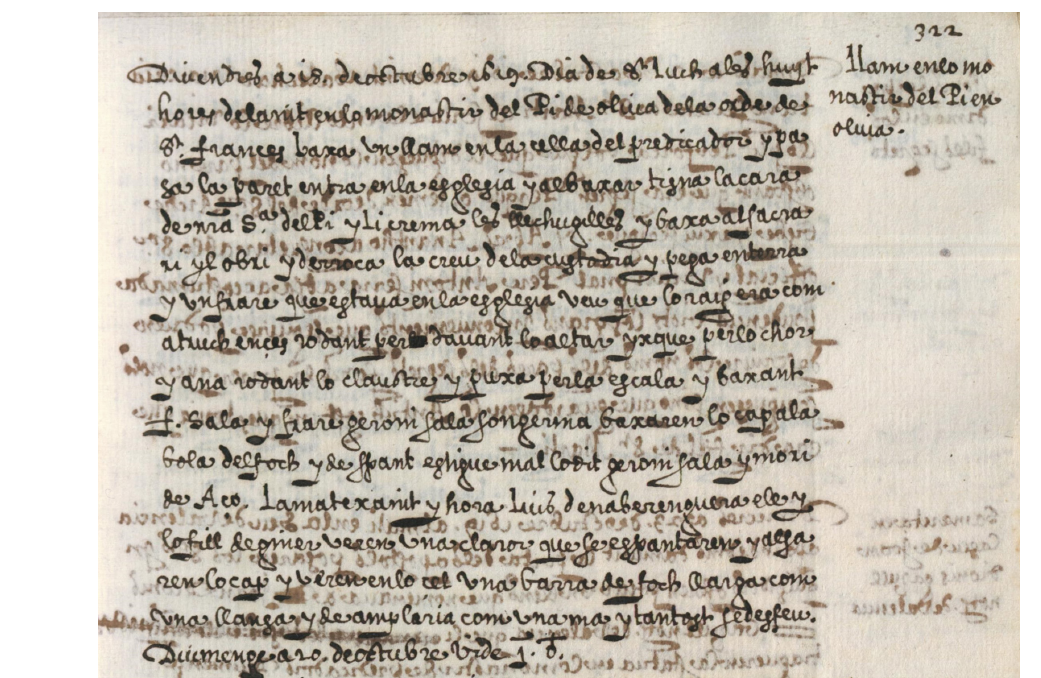
Figure 1. Detail of the manuscript Coses evengudes en la ciutat y regne de Valencia (courtesy of the Real Academia de la Historia).